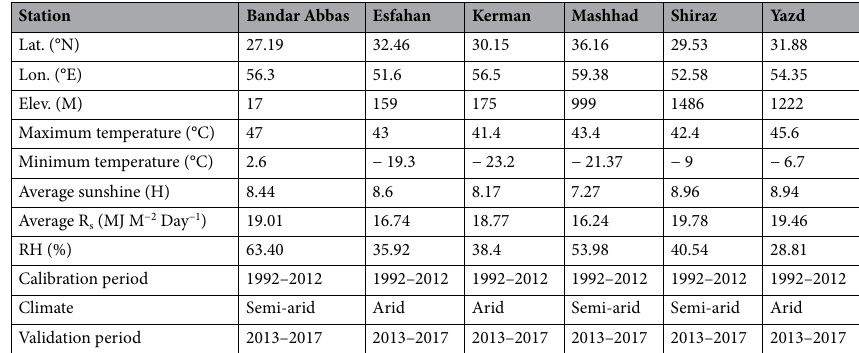
Table 1. Geographical and meteorological characteristics for the studied